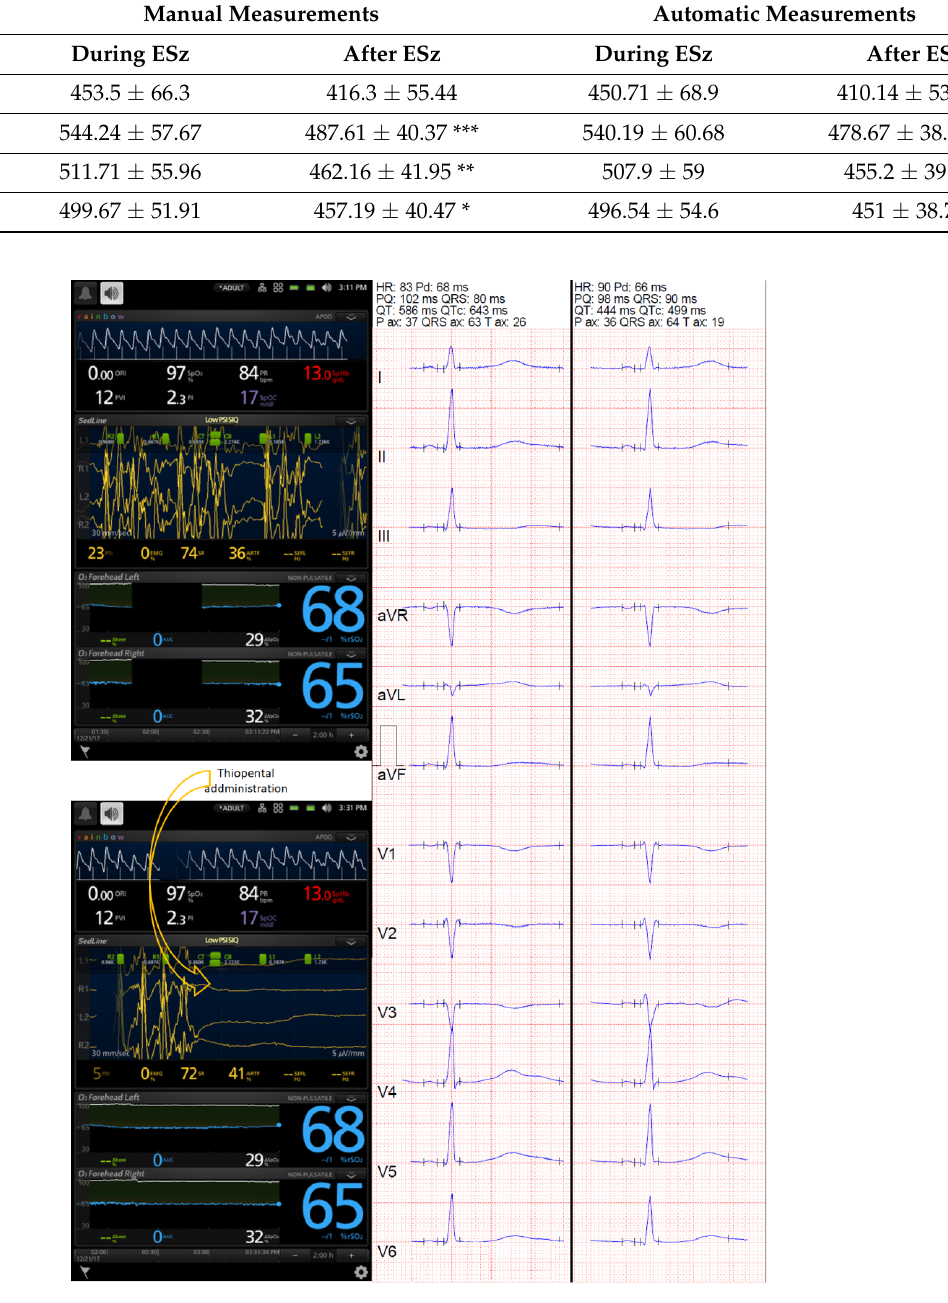
Figure 2. Changes in frontopolar electroencephalography monitored with Masimo Root device and corrected QT (QTc) interval. Prolonged QTc interval was noted during ESz, and use of thiopental suppressed the seizure successfully, which was associated with a reduction in the automated QTc (from 643 to 499 ms, calculated with Bazett’s formula, and from 610 to 475 ms and 591 to 471 ms, calculated with Fridericia’s formula and Framingham’s formula, respectively). However, the ECG showed bifid T waves in V 4 , V 5 , and V 6 leads before suppression and in II, III, aVF, V 3 , V 4 , V 5 , and V 6 15 min after ESz suppression, leading to partially spurious automated QTc results. Frontopolar EEG monitoring with the Masimo device showed seizures (upper screenshot) and their spectacular suppression following barbiturate infusion (lower